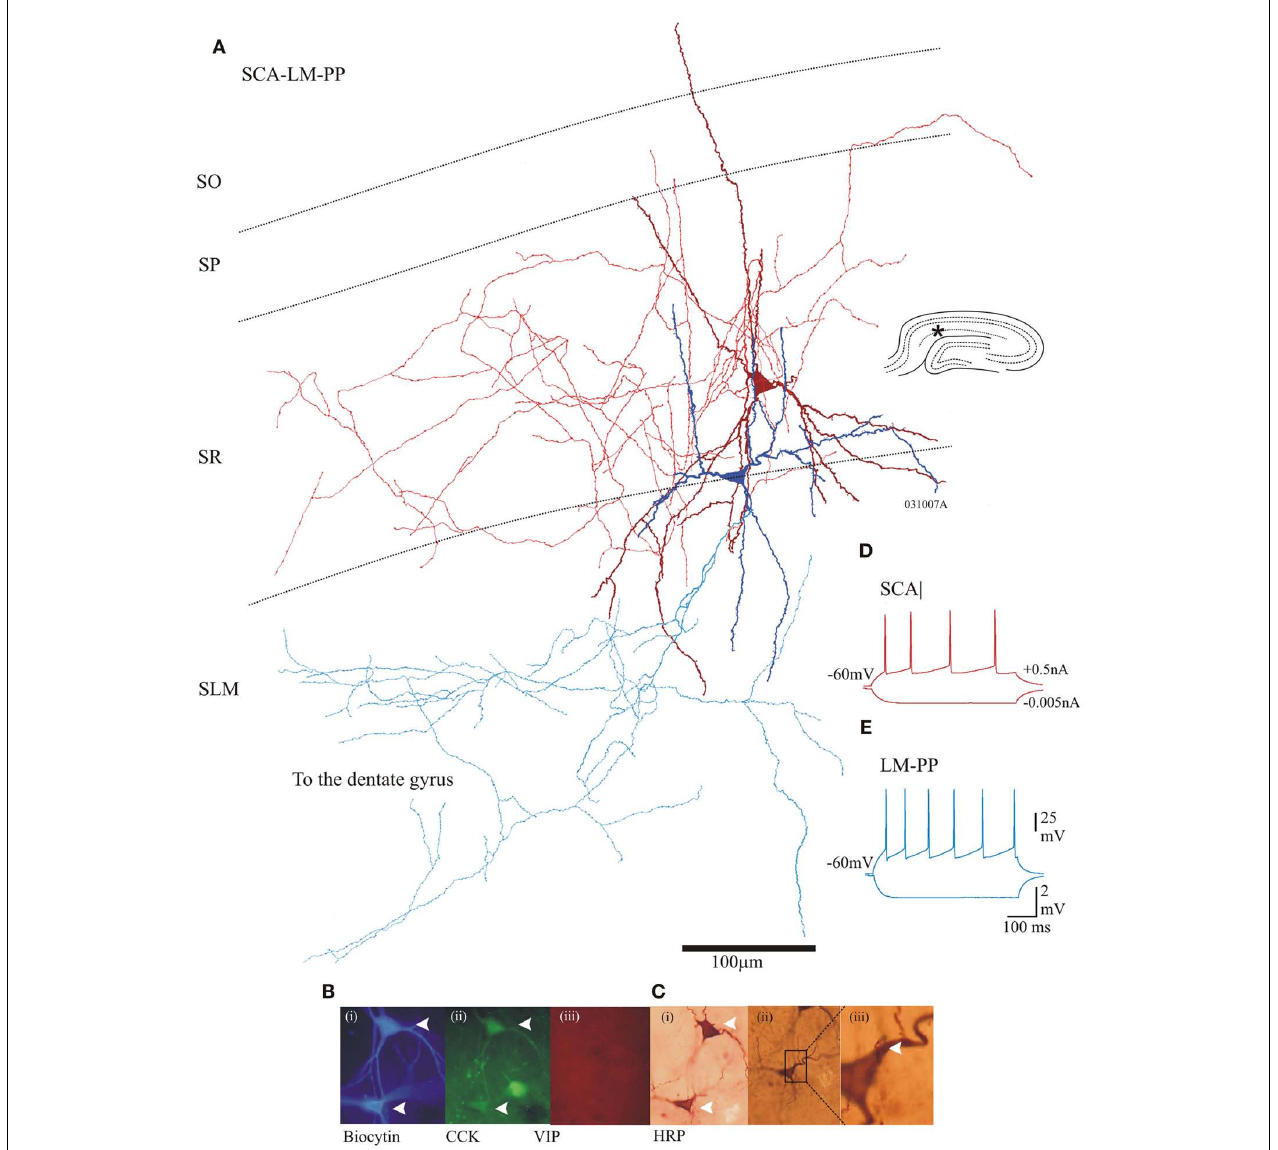
AMCA-Avidin labeling of biocytin-filled pair, (ii) green shows positive CCK labeling of biocytin-filled cells (closed arrows); (iii) in red,VIP labeling showing absence of staining in cells of interest. (C) (i) Photomicrograph of a permanent DAB-stain of both cells. (ii) An SCA to LM–PP dendro-somatic apposition, which is shown enlarged in (iii). (D,E) Adapting firing properties of the recorded SCA and LM–PP cells in response to − 0.005 and + 0.5nA current